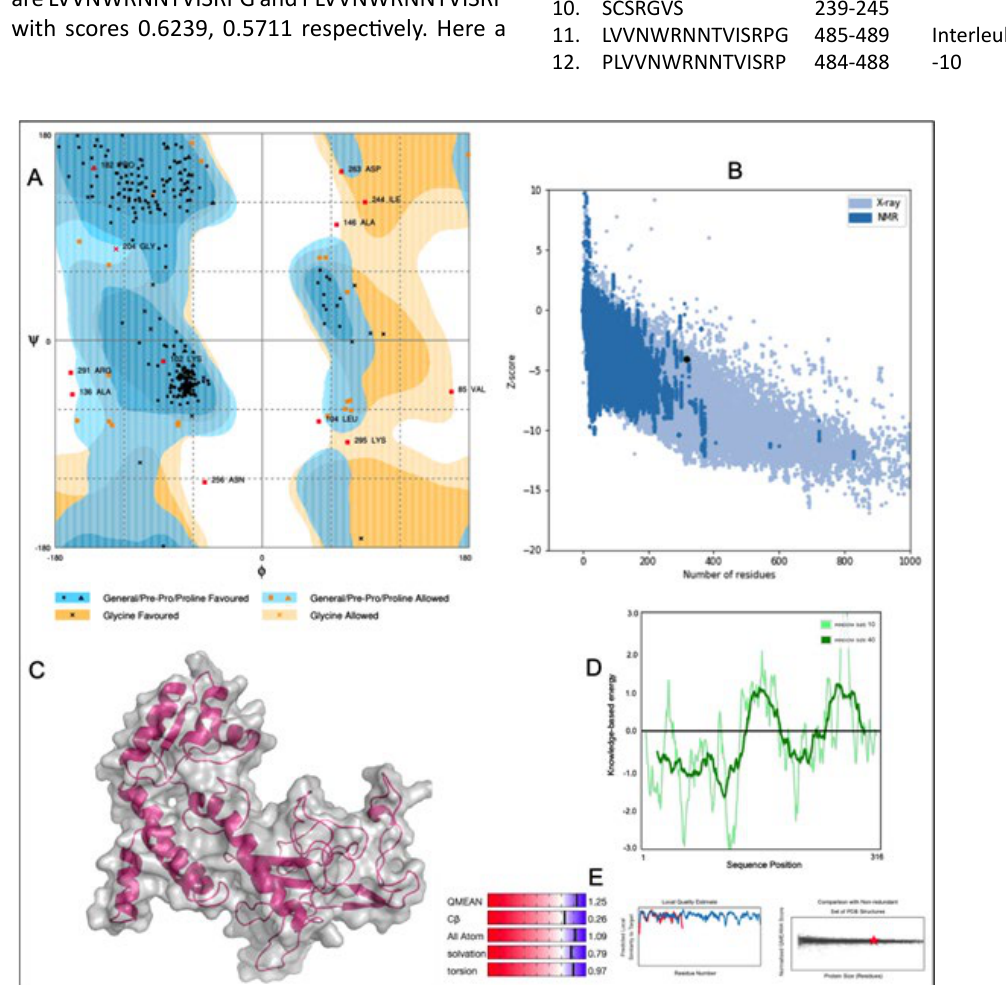
Fig. 5. (A) RAMPAGE derived Ramachandran plot for Multi-epitope vaccine construct (B) Z-plot showing the 3D model score to be within known structures derived through X-ray and NMR (C) 3D model of the chimeric vaccine construct (D) Energy per residue (E) QMEAN4 analysis of the vaccine construct.